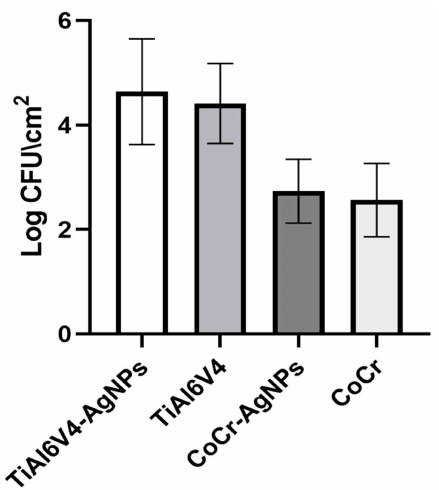
Figure 1. Log population density (means and standard deviations) for each material evaluated.